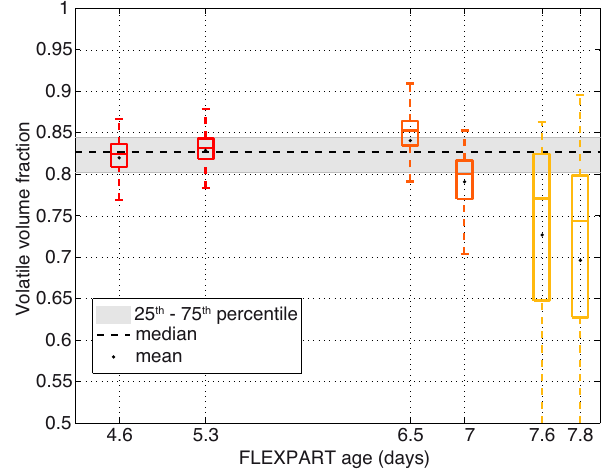
Fig. 7a. Evolution of the enhanced carbon monoxide mixing ra- tios (ppbv) as a function of FLEXPART age for the anthropogenic plume samplings. An exponential fit is shown. For each boxplot, the central line is the median, edges of the box are 25th and 75th per- centiles and the dotted line extends to the 5th and 95th percentiles. The mean is indicated by black dots.